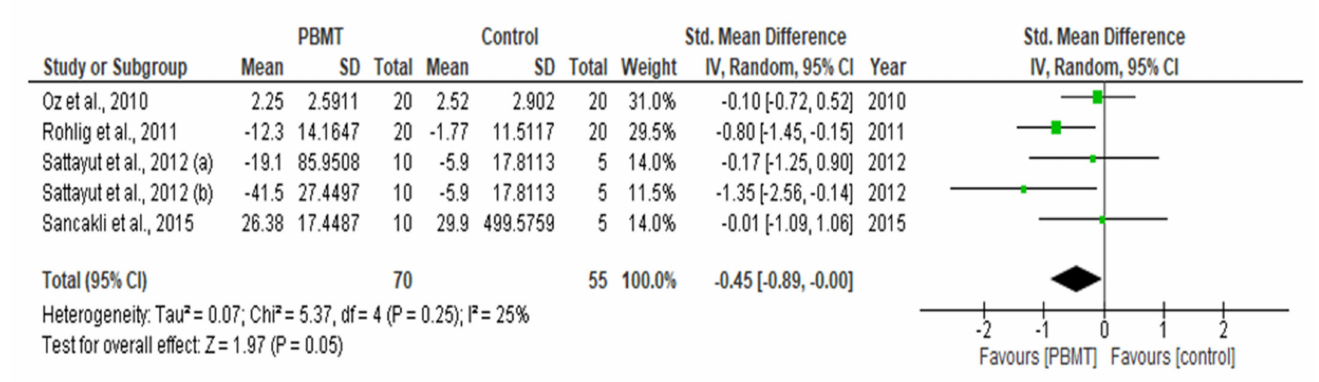
Figure 6. Forest plot for secondary outcome quantitative pain reduction assessment (PPT) from baseline up to the final follow-up timepoint.